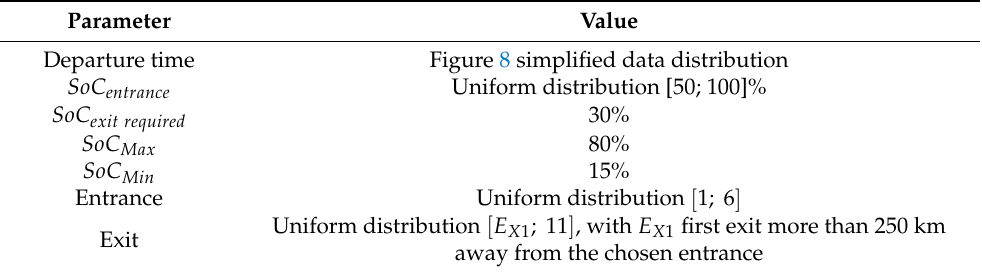
Table 2. Parameter selection.